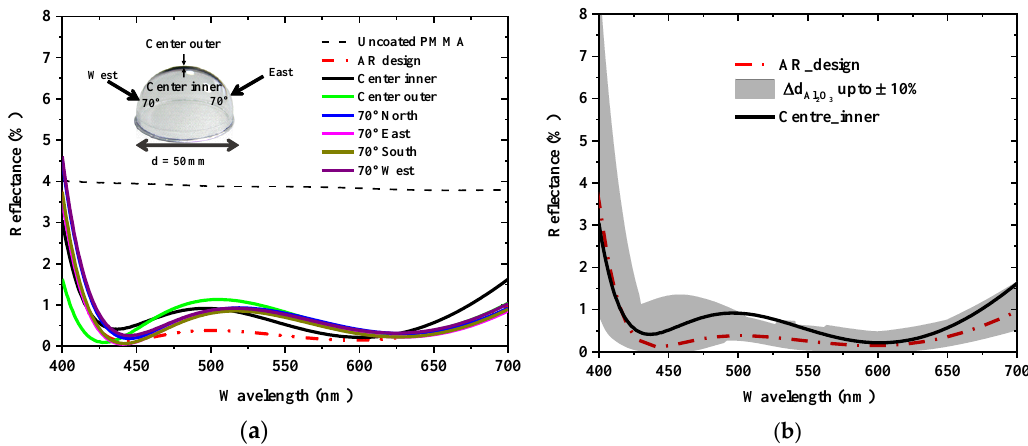
Figure 4. ( a ) Measured reflectance at the center positions of the outer and inner surfaces of the PMMA dome and reflectance at 70 ◦ tilted position of the dome in four directions on the outer surface, ( b ) Reflectance at the center position of the inner surface of PMMA dome along with the AR design and 10% tolerance of Al 2 O 3 film thicknesses.